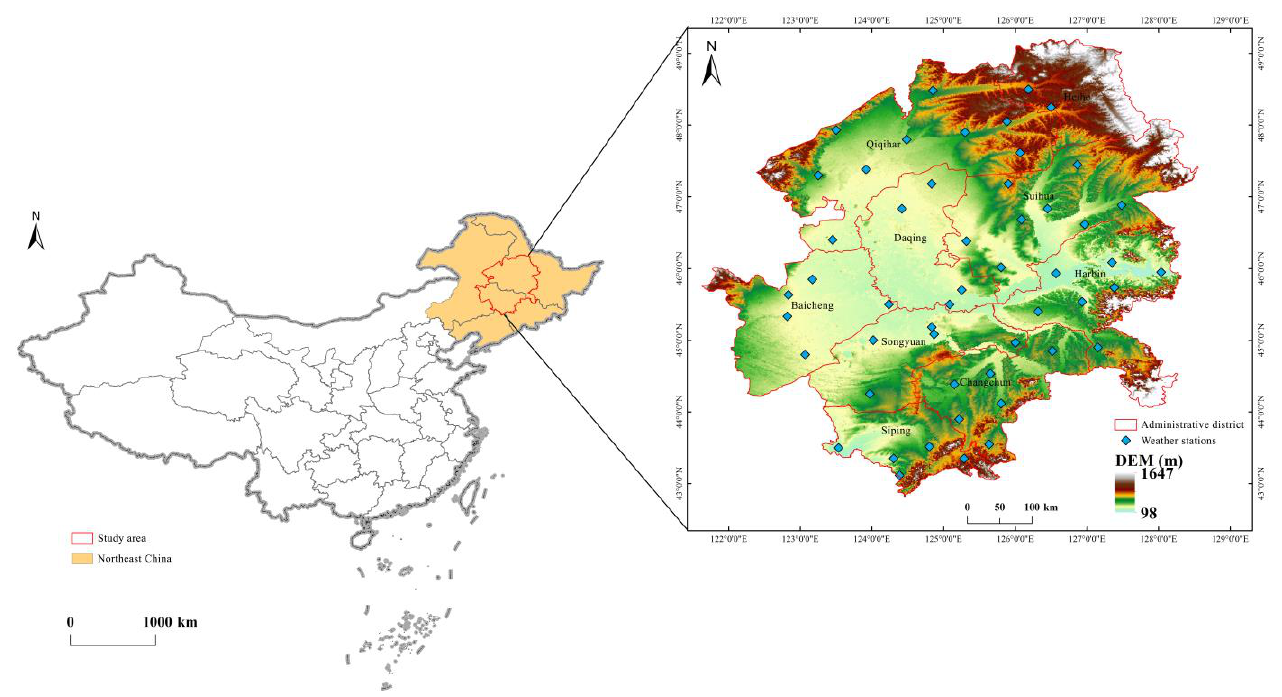
Figure 1. The location of Songnen Plain in Northeast China and distribution of meteorological stations.